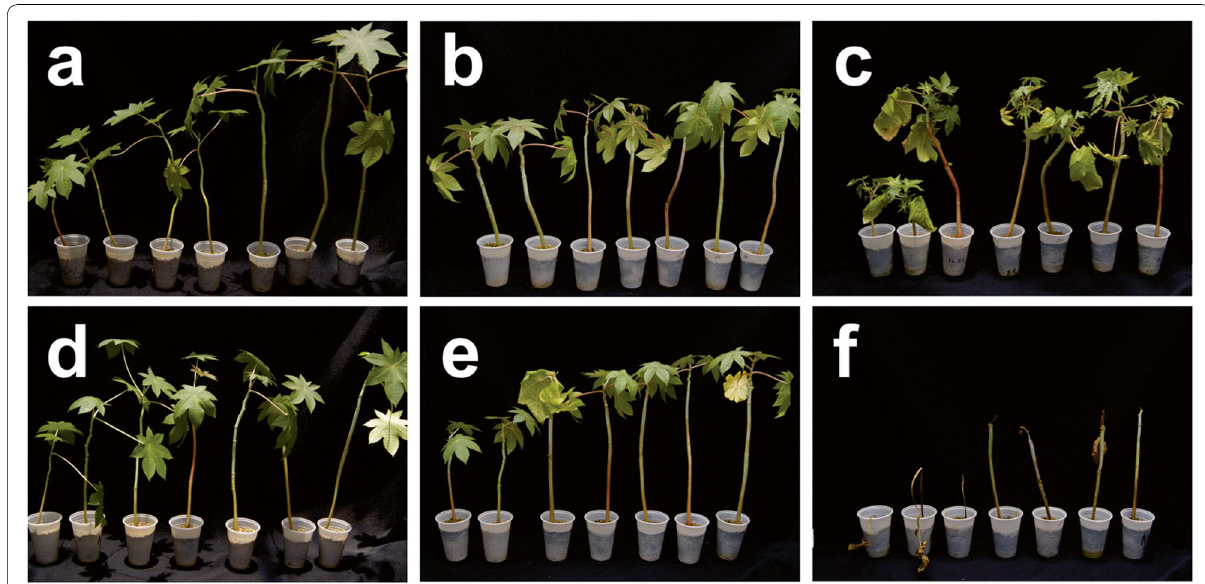
Fig. 2 Evaluation of transgenic castor bean event TB14S-5D at 75 days post application of herbicide. Twenty-one day-old plantlets from the transgenic ( a – c ) and non-transgenic ( d – f ) lines. Plantlets were sprayed with 0 g ha − 1 ( a and d ), 100 g ha − 1 ( b and e ), 250 g ha − 1 ( c and f )